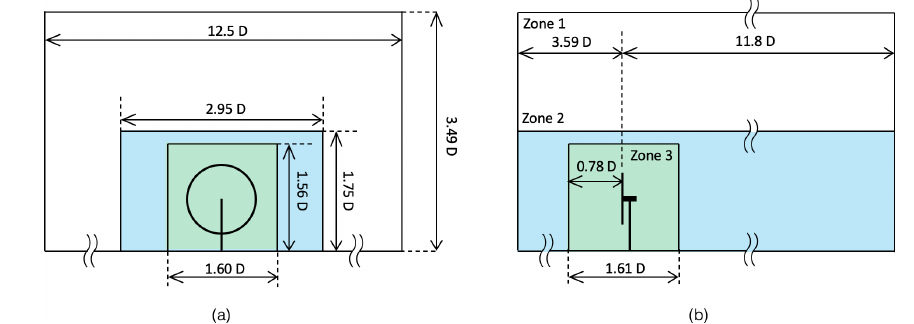
Figure 4. Frontal (a) and lateral (b) views of the computational domain and refinement zones used for the wind turbine simulations. Precursor simulations were used to generate turbulent inlet conditions at a plane 3.59 D upstream of the rotor disk. The cell size in the three zones is 0.055, 0.027 and 0.014 D , respectively.